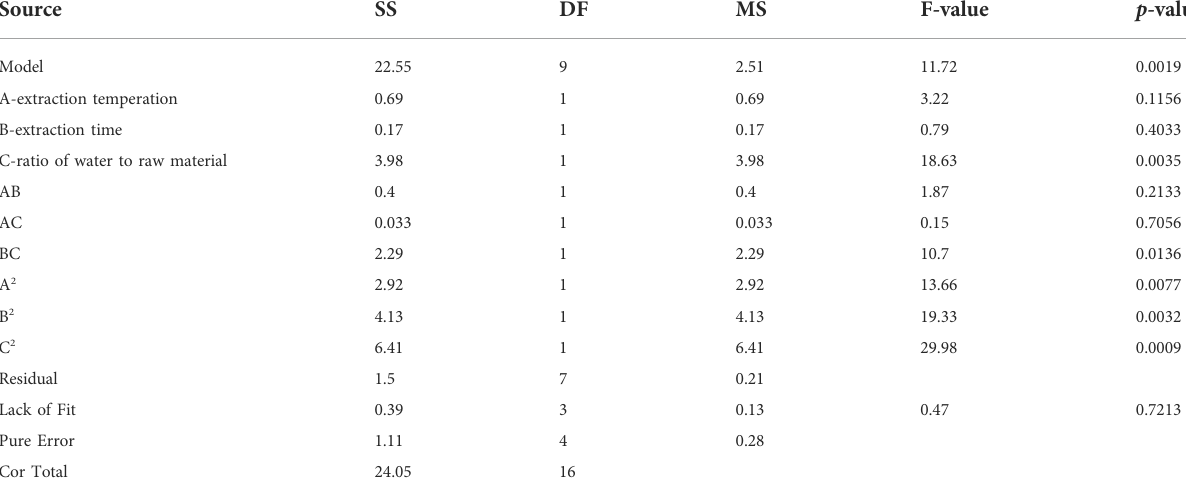
TABLE 3 Analysis of variance (ANOVA) results for response surface optimization of the RFP extraction process.